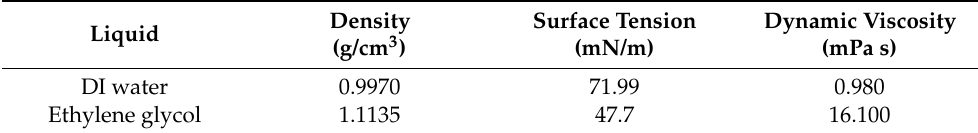
Table 1. Property of liquids used in the experiments [31].